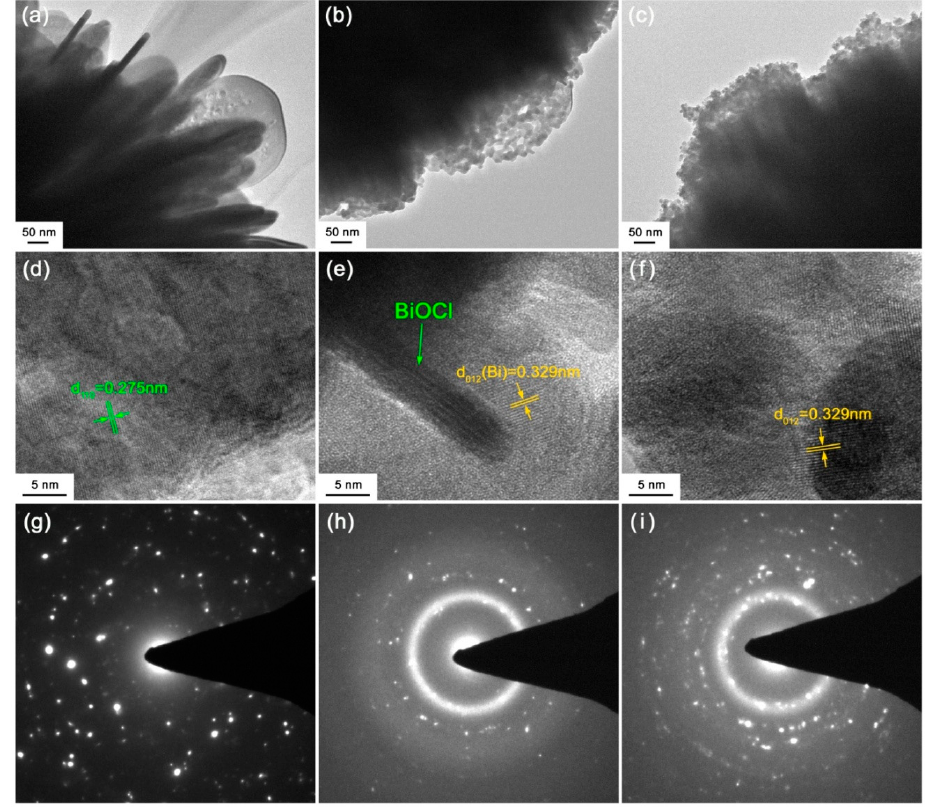
Figure 4. ( a – c ) TEM images of pristine BiOCl, 30mM-30min-BiOCl and 120mM-30min-BiOCl, respectively. ( d – f ) HRTEM images of pristine BiOCl, 30mM-30min-BiOCl and 120mM-30min-BiOCl, respectively. ( g – i ) SAED patterns of pristine BiOCl, 30mM-30min-BiOCl